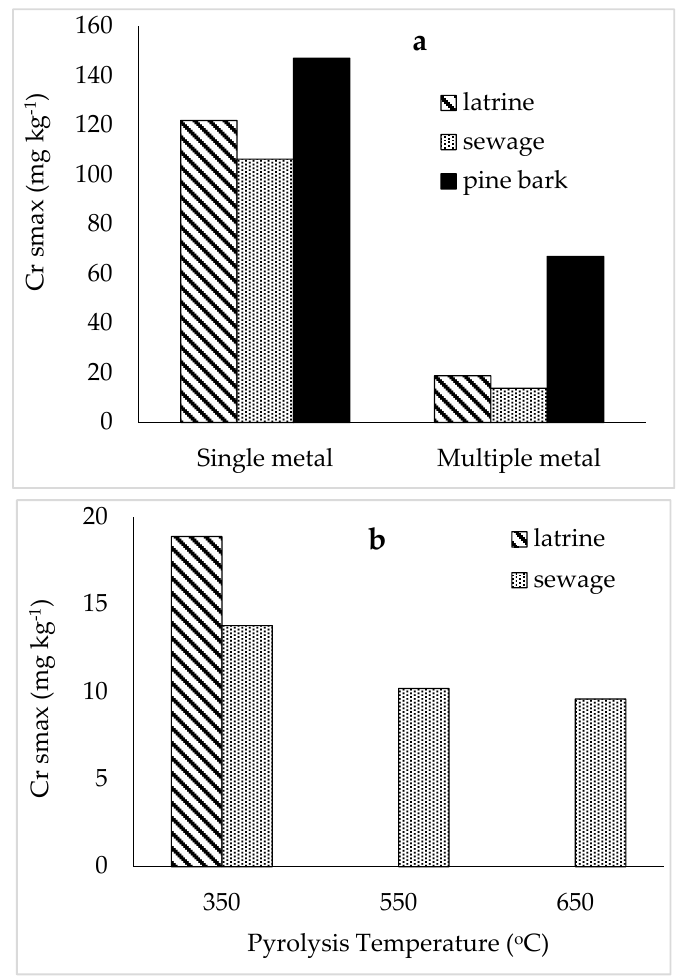
Figure 5. Sorption isotherms of chromium from: ( a ) effluent on biochar pyrolysed at 350 °C, ( b ) single metal on biochar pyrolysed at 350 °C and ( c ) effluent on biochar pyrolysed at 550 and 650 °C. LW =